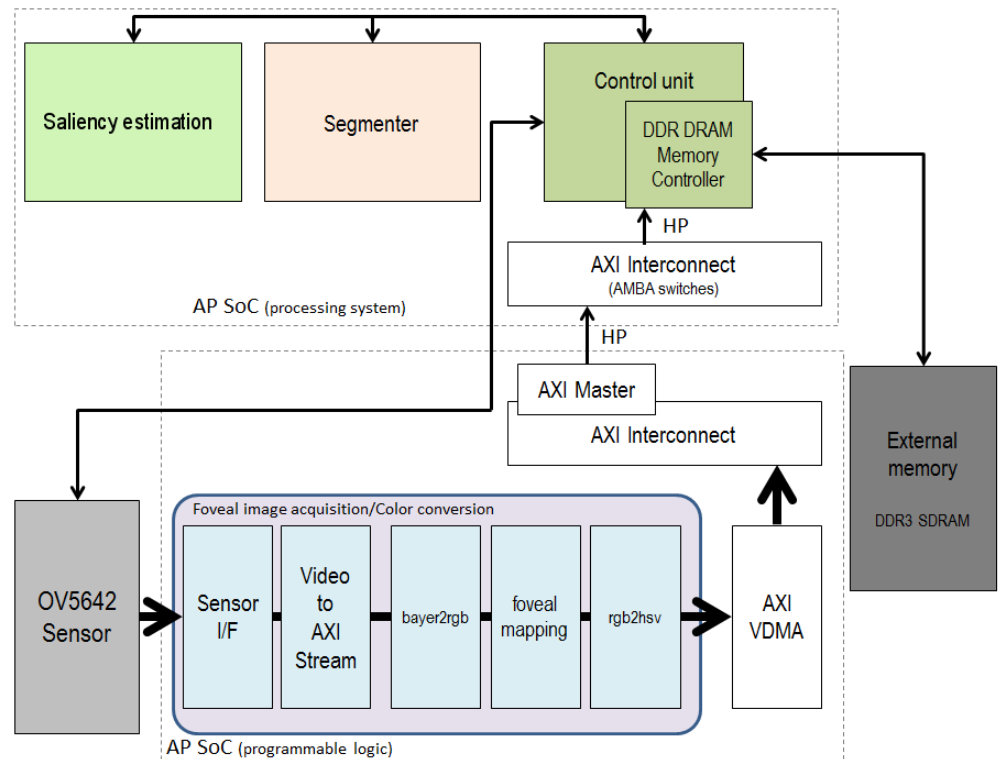
Figure 4. Block diagram of the